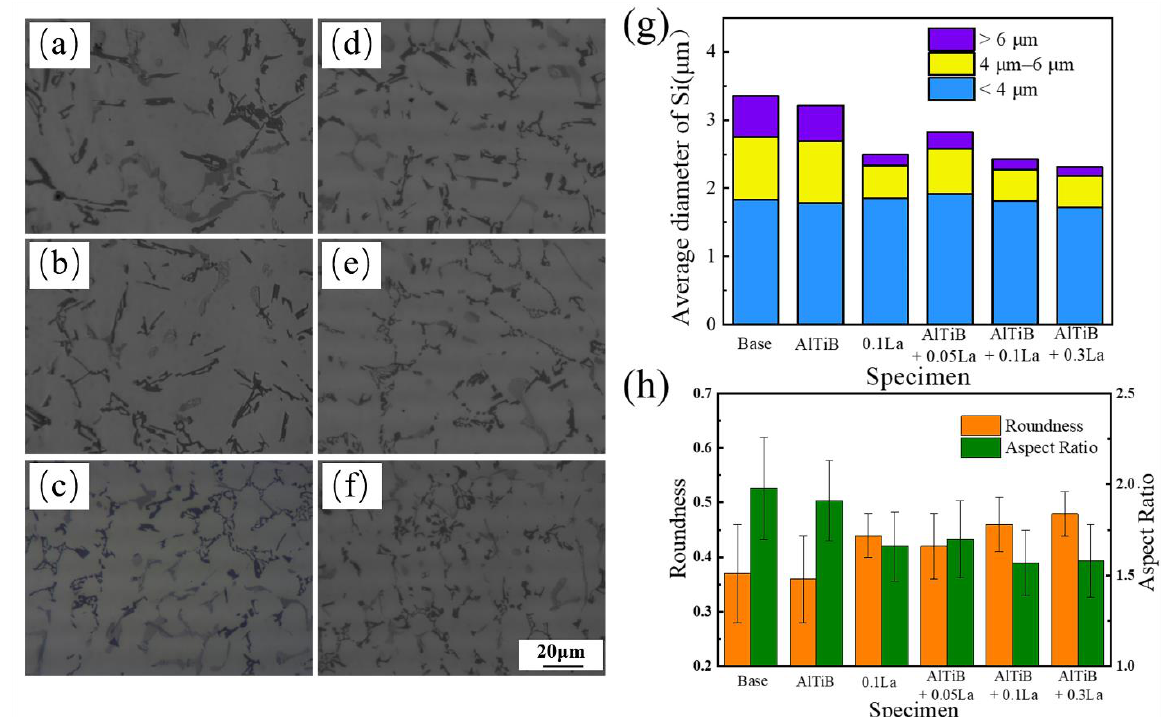
Figure 4. Optical microstructure and morphological characteristics statistics of eutectic Si particles: ( a ) Base; ( b ) AlTiB; ( c ) 0.1La; ( d ) AlTiB + 0.05La; ( e ) AlTiB + 0.1La; ( f ) AlTiB + 0.3La; ( g ) Average equivalent diameter and number distribution of different sizes; ( h ) Roundness and aspect ratio statistics.